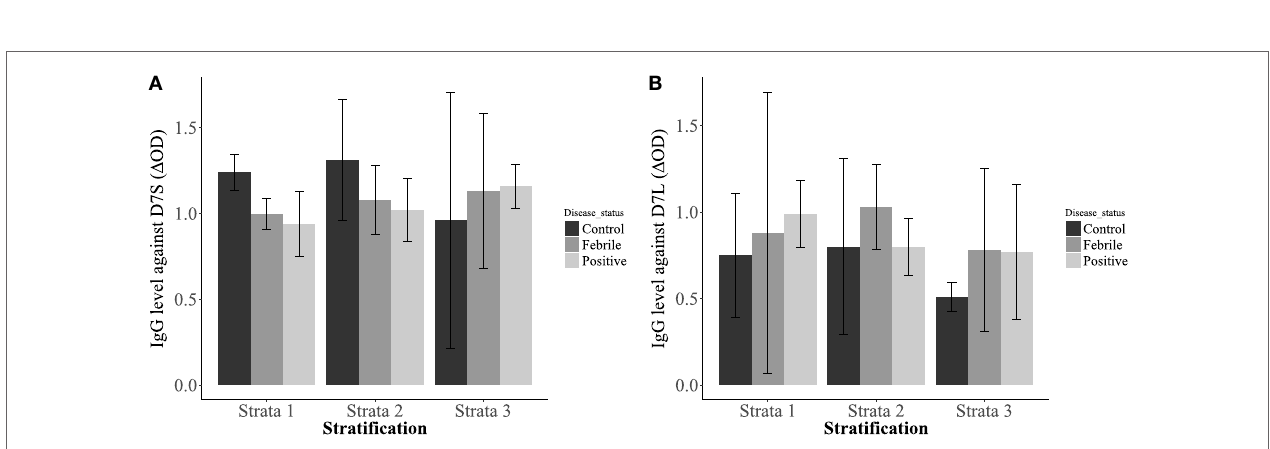
FigUre 4 | Interaction plots showing the concentrations of IgG antibodies against D7 short (a) and D7 long (B) when evaluated against the patient disease status: non-febrile subjects (control) ( n = 12), febrile subjects ( n = 12), and dengue virus positive subjects ( n = 37) and living conditions [stratum 1: lower-low conditions ( n = 23), stratum 2: low conditions ( n = 26), and stratum 3: upper-low conditions ( n =